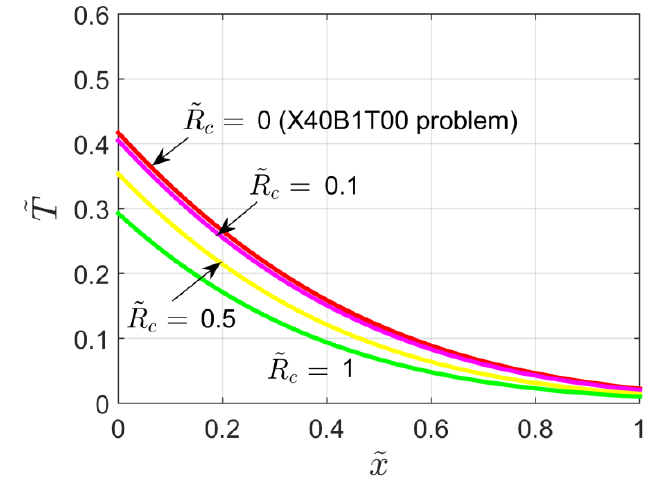
Figure 8. Dimensionless temperature distribution for the X60B1T00 problem for different values of the dimensionless contact resistance.